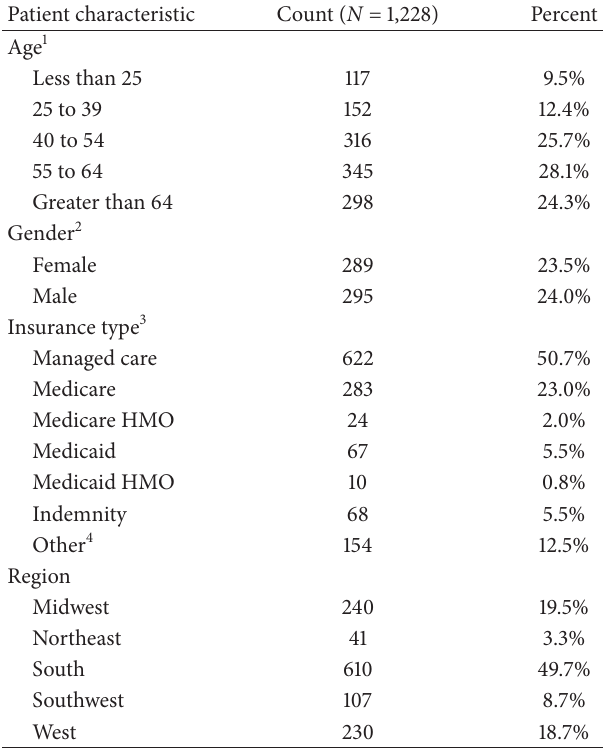
Table 1: Patient characteristics for mSTS